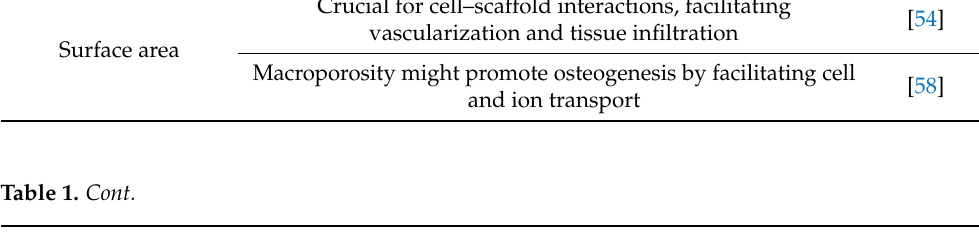
Table 1. Cont. Microporosity improves surface area for protein adsorption, increasing ionic solubility and attachment points for